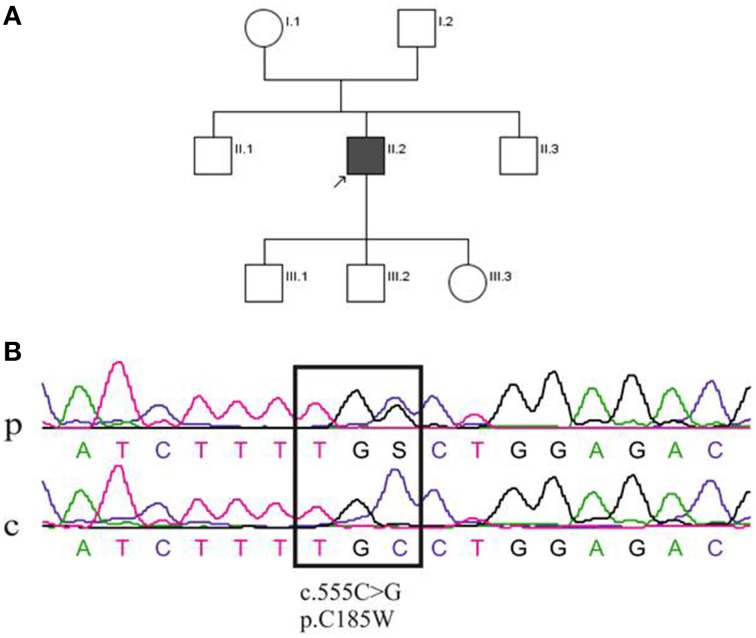
(A) Pedigree of the family of the patient (II.2). (B) Sequence analysis of the KCNA1 gene mutation. DNA sequence from the patient (p; II2) and a control individual (c). The upper sequencing profile shows the heterozygous single nucleotide change at position c.555C > G, which leads to a cysteine (C) to tryptophan (W) substitution (p.C185W) in the protein Kv1.1.